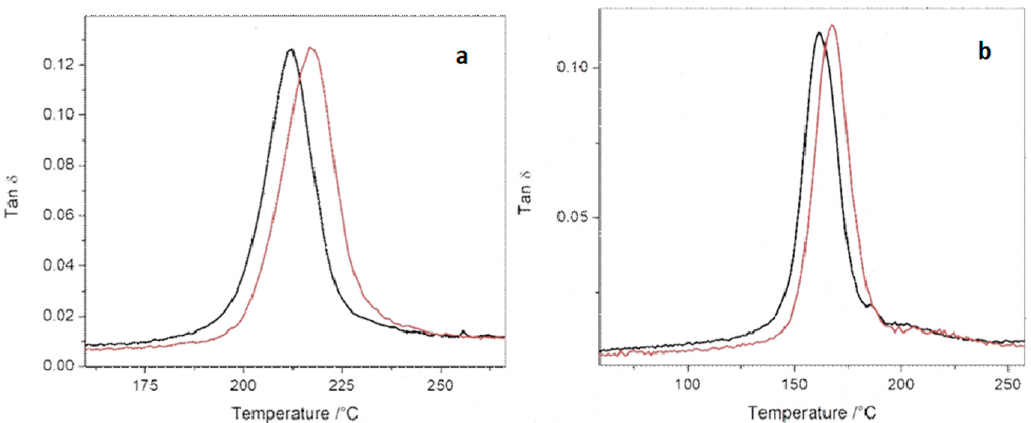
Figure 8. Tan δ versus temperature curves for ( a ) P(ESES) and ( b ) P(ESDPA) polymers: 1 Hz black line, 10 Hz red line.